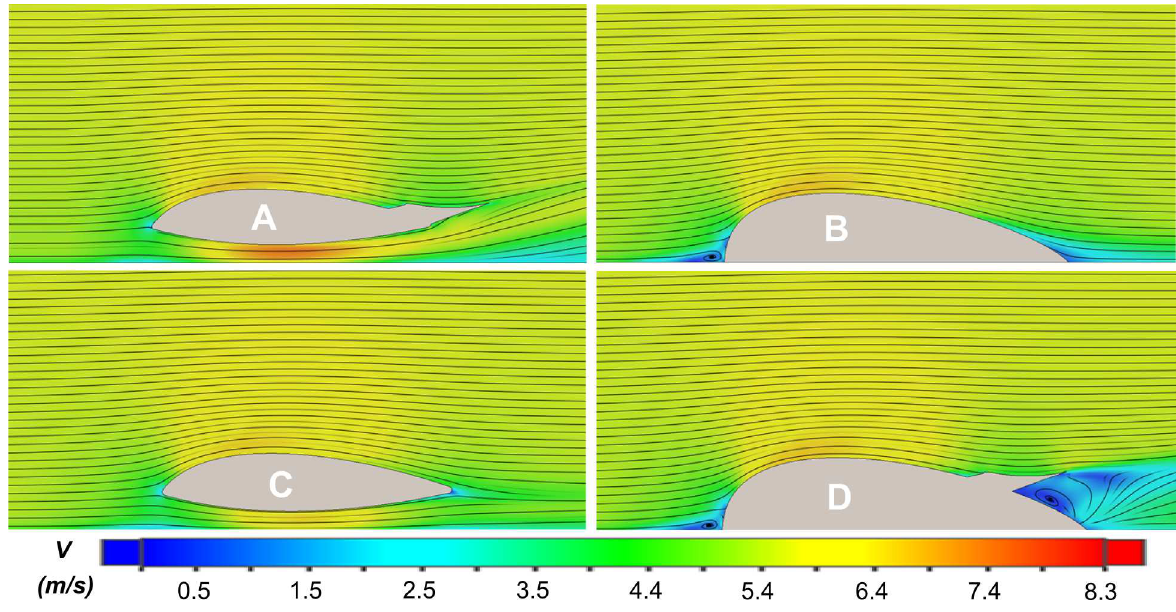
Fig 5. Longitudinal cross-section views in 5.6 m/s inline flow with a color map corresponding to the speed of the fluid flow ( V ). Areas of low speed are shown in blue, whileareas of high speedare shown in red. doi:10.1371/journal.pone.0170962.g005 and the streamlines of the fluid for inline 5.6 m/s flow are shown in Figs 5 and 6. Beginning with the design derivatives, the flow around the Model B tag remains attached to the surface as the hydrodynamic form redirects fluid around the body. The airfoil-like shape accelerates the fluid over the top of the tag creating the lift-generating area of low pressure (Figs 5 and 6; top right). The flow interface at the front of the Model B design creates some fluid damming,